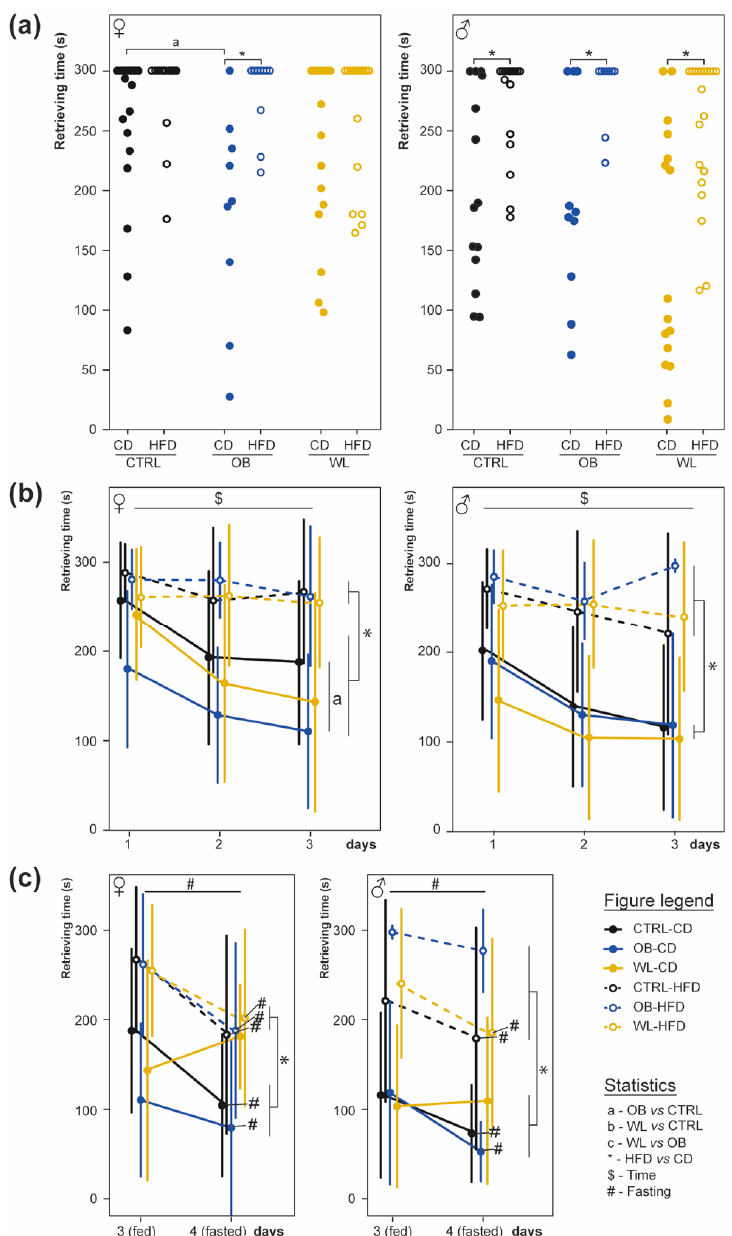
Figure 4. High fat post-weaning diet decreases mice performances in a general anosmia test. The hidden-cookie test measured the effect of maternal and post-weaning diet on general olfactory acuity at 2 months, after 4 – 5 weeks of post-weaning diet. The test was performed for 3 days (two averaged trials per day) in a fed state and on the 4th day after 8-h fasting. Latencies to find the buried cheese on the first day ( a ), their evolution between day 1 and 3 ( b ) and between day 3 (fed) and 4 (fasted) ( c ) are presented as scatterplots or mean ± SD for female (left; CTRL-CD n = 19, CTRL-HFD n = 20, OB-CD n = 9, OB-HFD n = 10, WL-CD n = 18, WL-HFD n = 16) and male (right; CTRL-CD n = 15, CTRL-HFD n = 16, OB-CD n = 10, OB HFD n = 9, WL-CD n = 16, WL-HFD n = 20) mice.